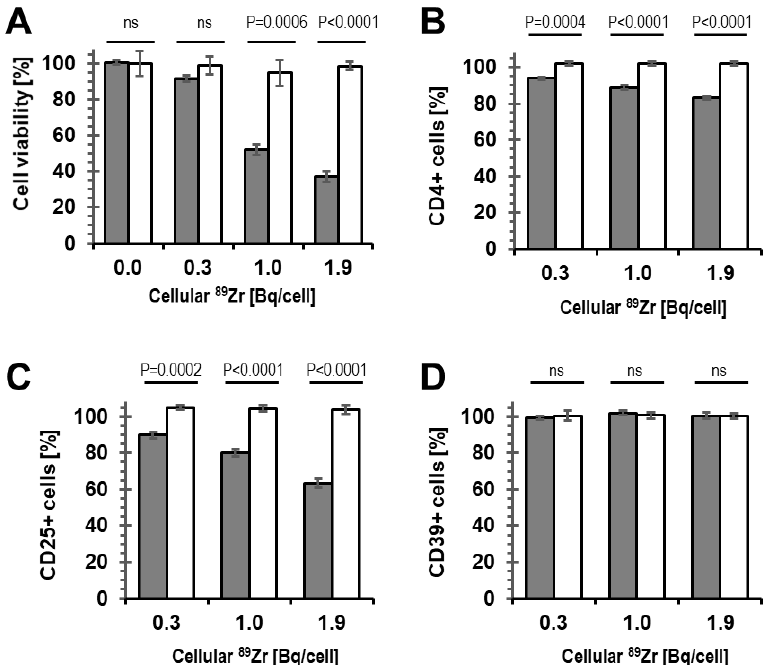
Figure 3. Viability and phenotype of 89 Zr-labelled human Tregs compared to mock-labelled Tregs. ( A ) Treg viability assessed following 72 h of culture after radiolabelling. Tregs were analyzed by flow cytometry for the percentage of cells expressing ( B ) CD4, ( C ) CD25, and ( D ) CD39 markers. Data are normalized to untreated Tregs. (Gray) 89 Zr-Tregs, (white) mock-labelled Tregs that do not contain 89 Zr; n = 3 for all experiments with error bars representing SD.